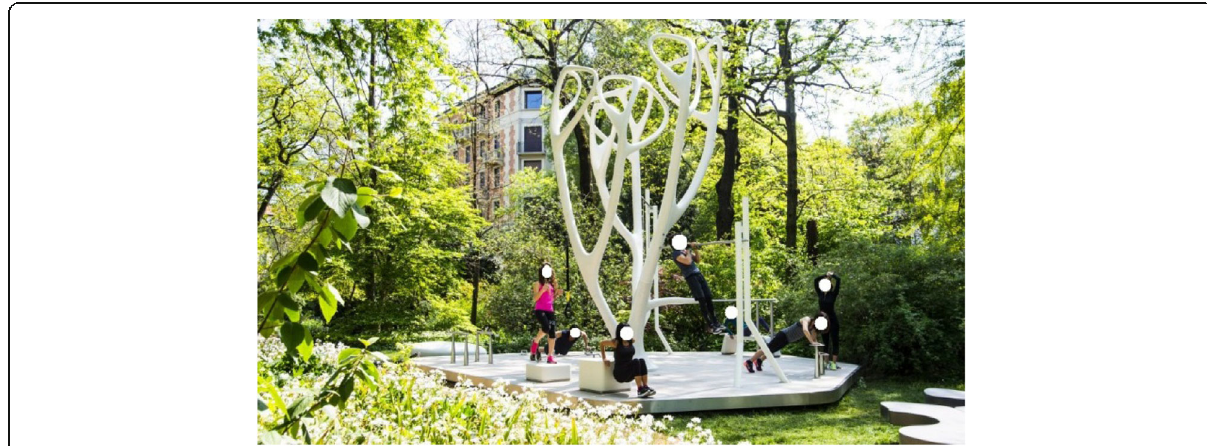
Fig. 3 Element of urban space, “ My Equilibria ” , designed by Vito Di Bari and Alfredo Tasca (source: http://www.myequilibria.com/myequilibria/)